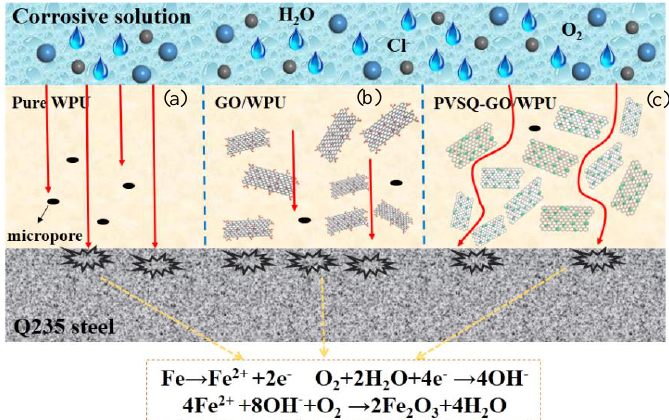
Figure 15. The possible corrosion protection mechanism of pure WPU ( a ), GO / WPU ( b ), and PVSQ-GO / WPU ( c ) composite coatings.